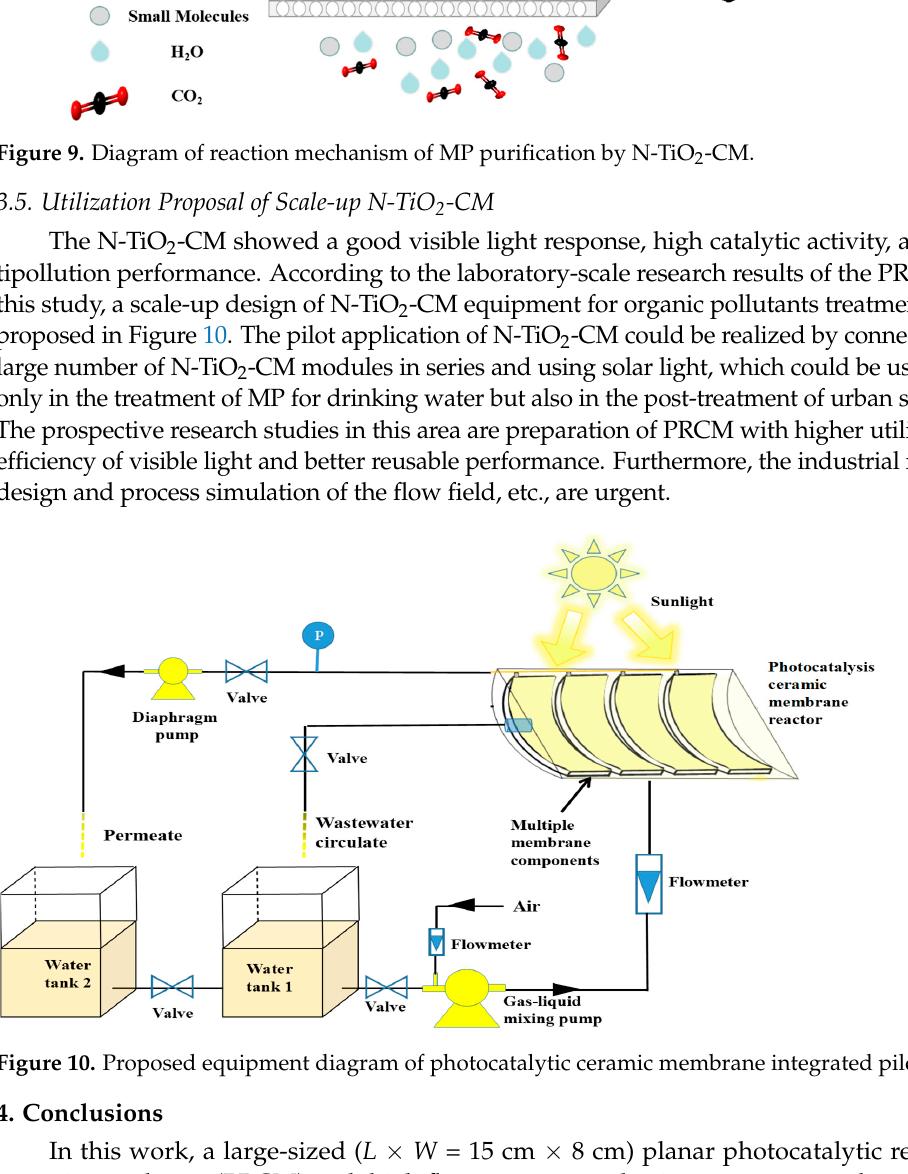
Figure 10. Proposed equipment diagram of photocatalytic ceramic membrane integrated pilot test.